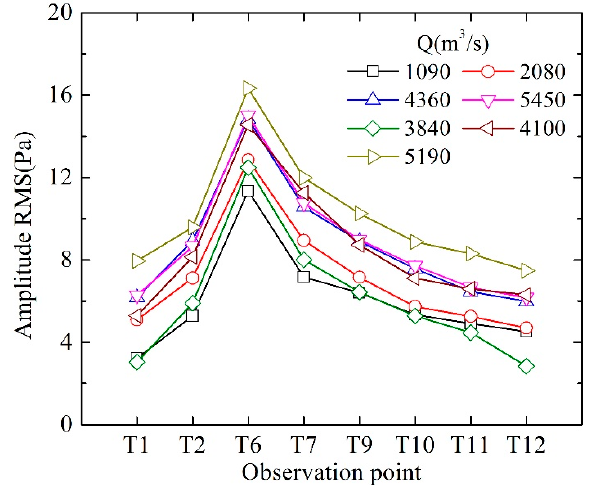
Figure 6. LFN amplitude distribution along the downstream river valley.